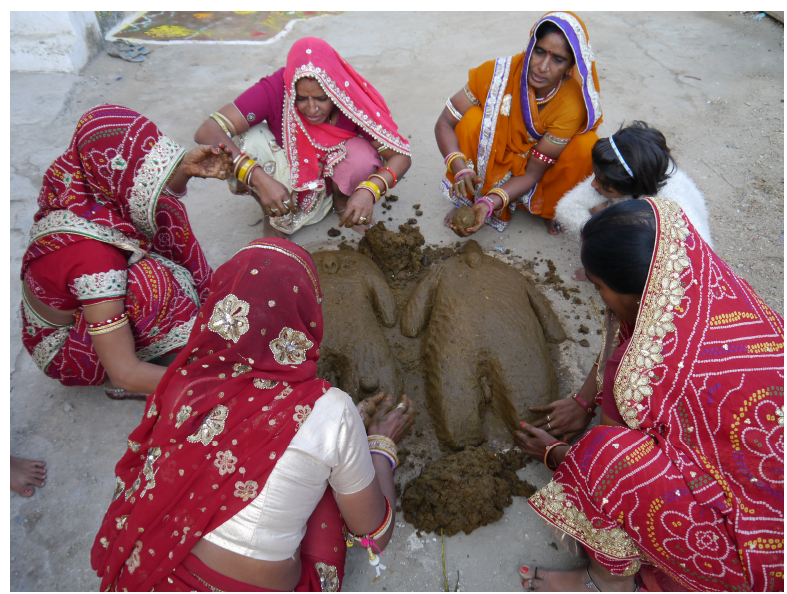
Figure5 Figure 5. Women crafting their kinship with land in cow dung, Badi, November 2018—Photo by Notermans.